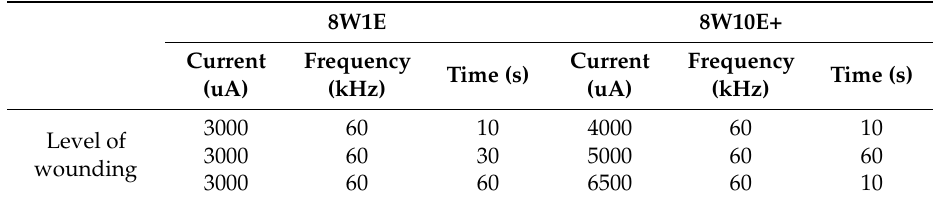
Details for levels of wounding applied to the 8W10E+ and 8W1E arrays using the ECIS-Z θ system. 8W1E